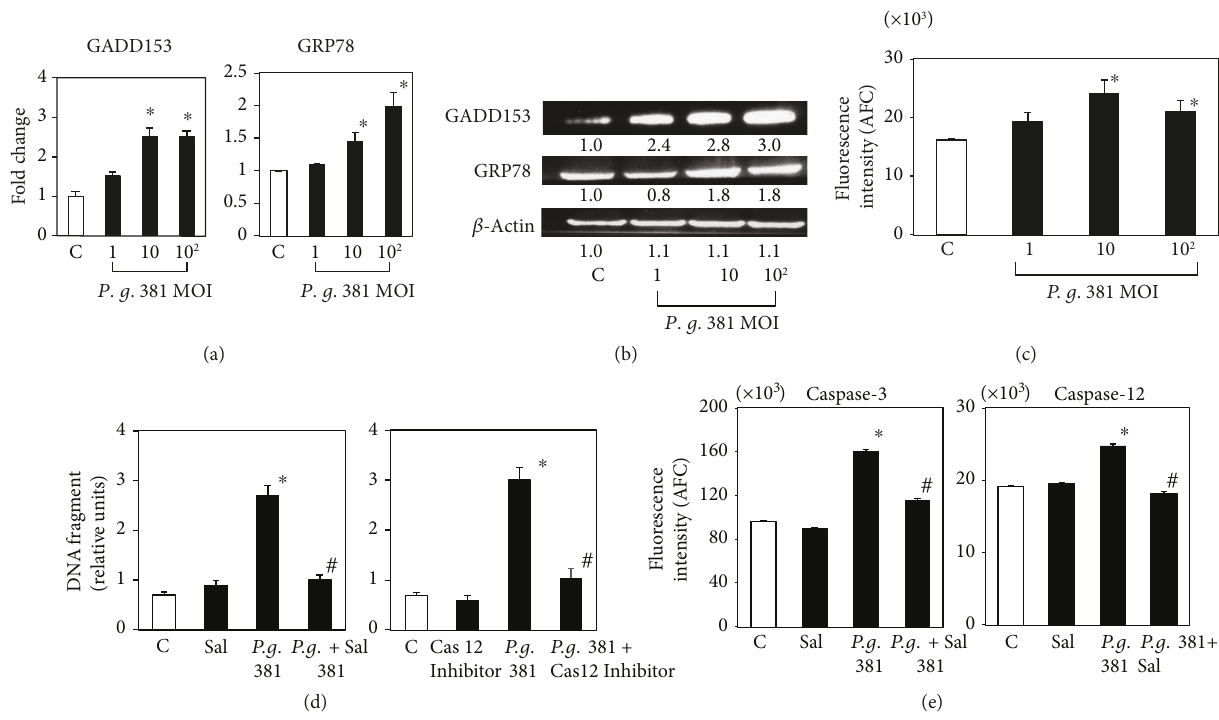
Figure 2: P. gingivalis 381 induces UPR-like response in HUVEC. (a) HUVEC were treated with P. gingivalis 381 at an MOI of 1:1 – 1 : 10 2 for 8h. Quantitative real-time PCR analysis was performed for GADD153 and GRP78 relative to β -actin expression. Data are expressed as the mean ± SEM of 3 di ff erent experiments. ∗ p < 0 01 versus bacteria-free control cells. (b) HUVEC were treated with P. gingivalis 381 at an MOI of 1:1 – 1 : 10 2 for 21 h. Whole cell lysates were subjected to SDS-PAGE, followed by Western blot analysis using antibodies to GADD153 and GRP78. Levels of β -actin were also detected as an internal control. The density of each band was measured by densitometry, and the relative band densities were calculated by comparing the band densities with those of the control. (c) HUVEC were treated with P. gingivalis 381 at an MOI of 1:1 – 1 : 10 2 for 16h. Cell extracts were then prepared, and caspase-12 activity was measured. Data are expressed as the mean ± SEM